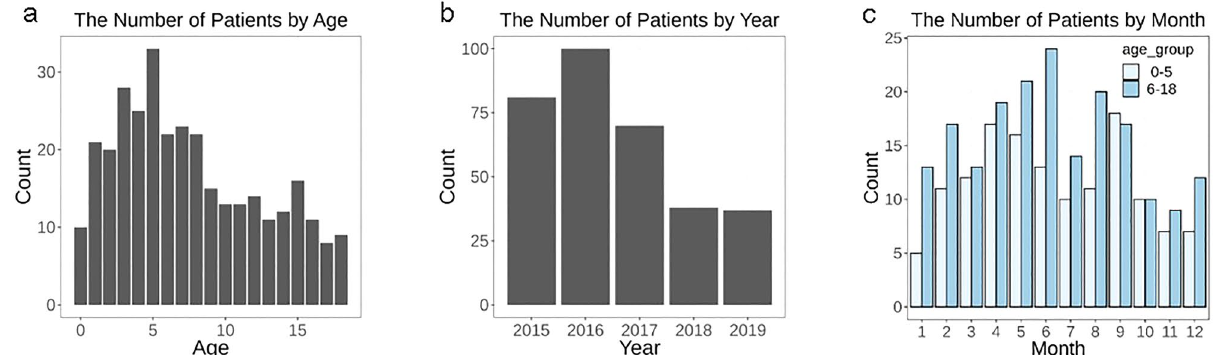
Figure 1. Age distribution of hospital epistaxis presentation from 2015 to 2019. ( a ) Age distribution of hospital epistaxis presentation. ( b ) Yearly distribution of hospital epistaxis presentation from 2015 to 2019. ( c ) Monthly distribution of hospital epistaxis presentation from 2015 to 2019.